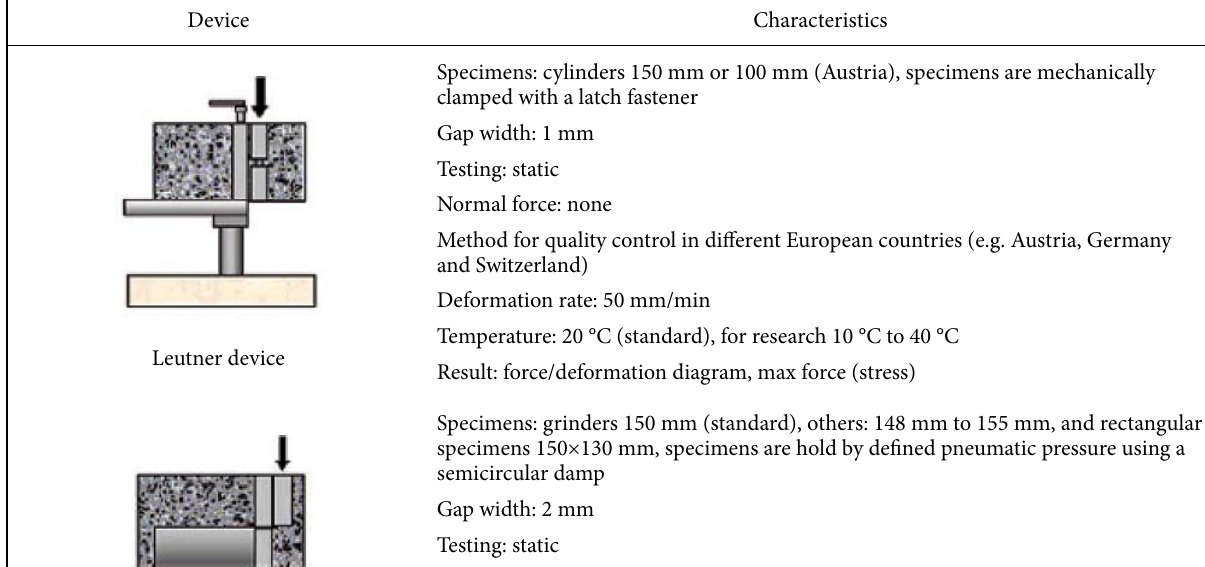
Table 1. Direct shear test devices (1)